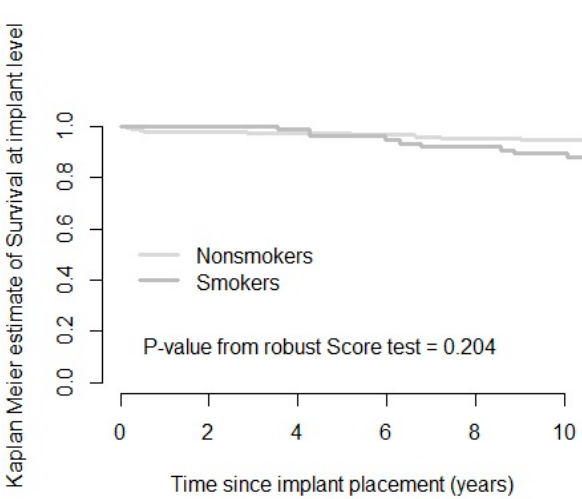
Figure 2. Kaplan–Meier survival curve showing estimated implant failures in the function of time for smokers and non-smokers on the patient level.